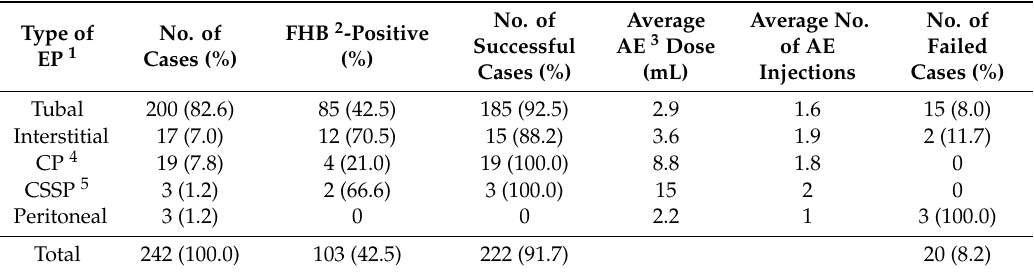
Table 1. Chorionic villi-targeted therapy with local injection of absolute ethanol for treatment of ectopic pregnancy conducted between April 2006 and December 2019.